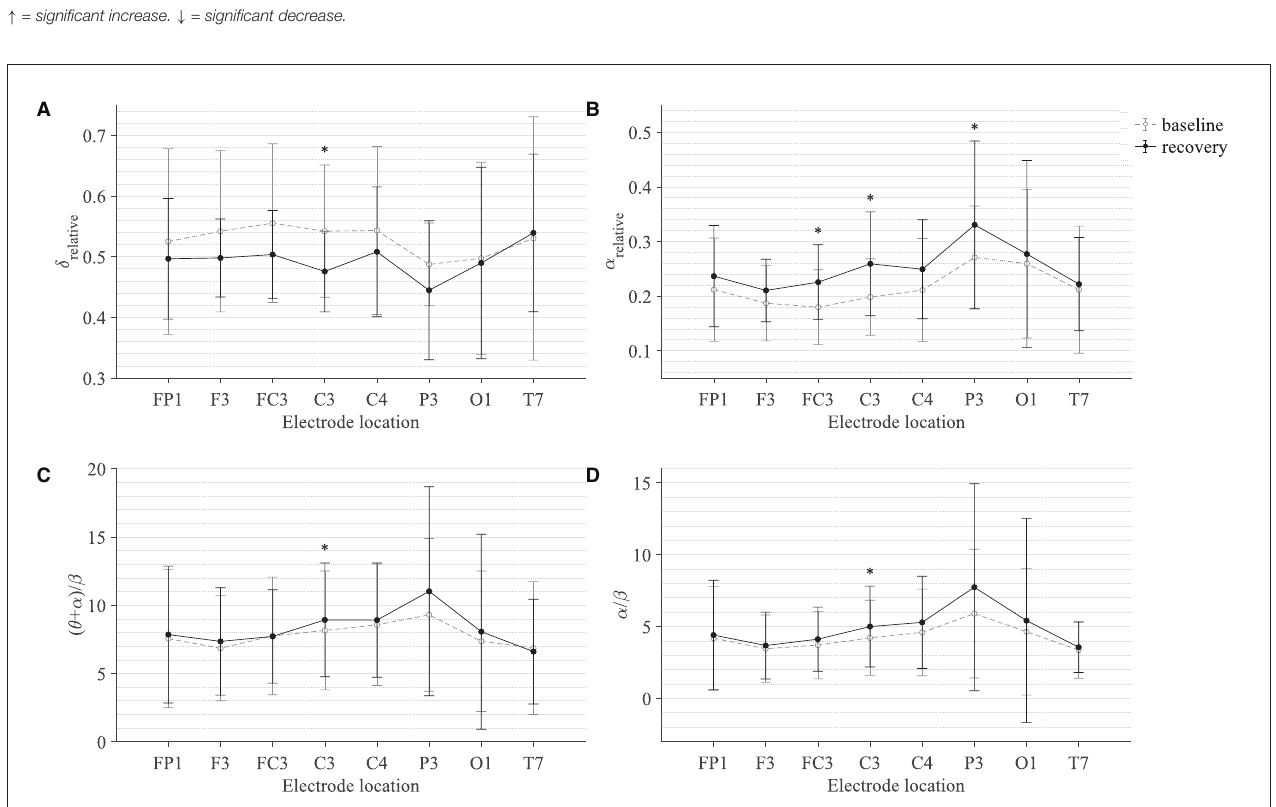
fatigue induced by the gross movements may have altered the EEG activity around the left central and left parietal